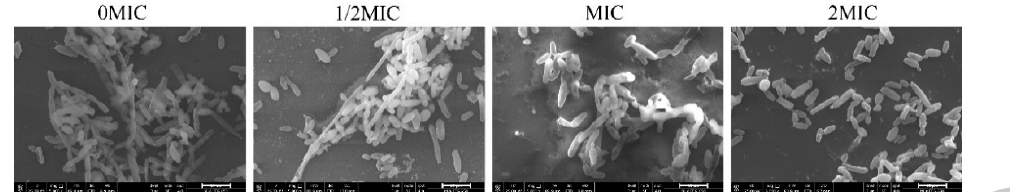
Figure 10. The effect of chelerythrine on C. albicans mature hyphae. Candida albicans mature hypha were formed in RPMI-1640 for 24 h and treated with indicated concentrations of chelerythrine for 5 h at 37 °C. Each field of vision was magnified 5000×. Scale bars represent 10 μ m.